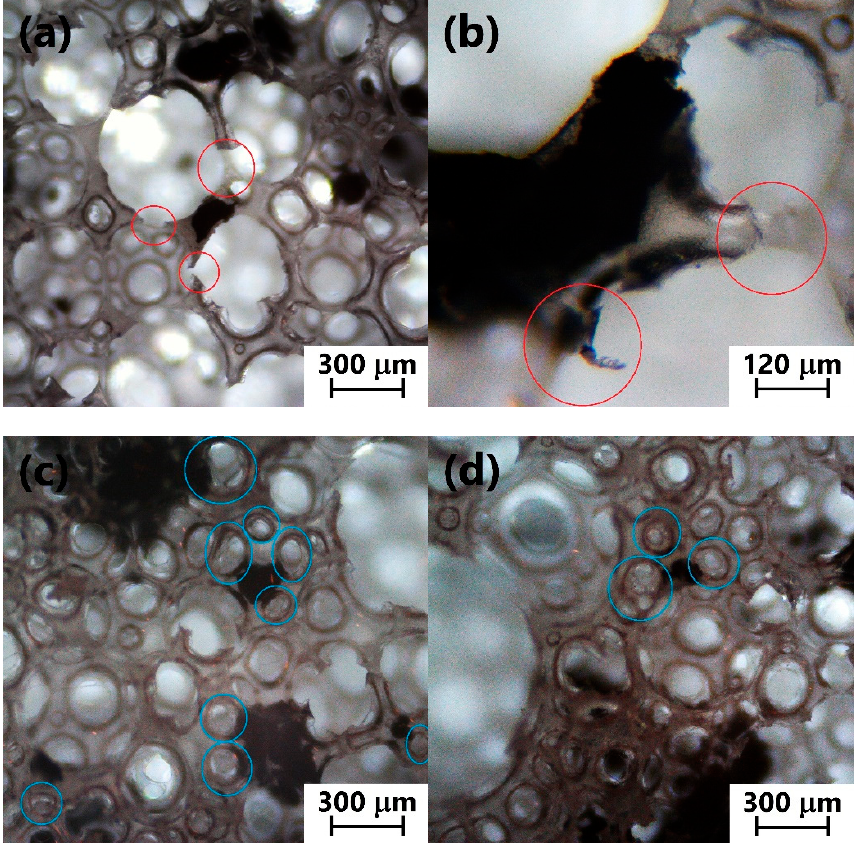
Figure 6. The effect of GTR type on the growth of open cells (red circles) and closed cells (blue circles) for ( a , b ) PU/GTR and ( c , d ) PU/GTR 40WO foams.